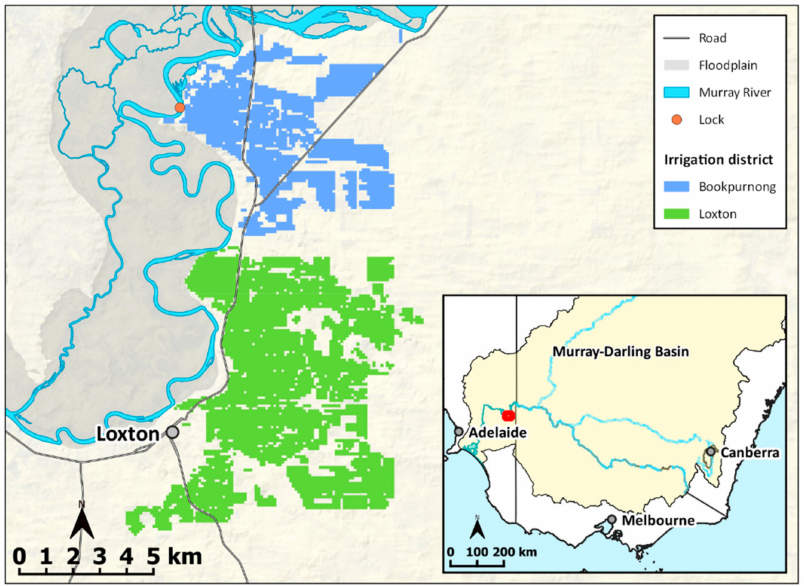
Figure 1. Location of the Loxton and Bookpurnong irrigation districts (the red marking on the inset map shows the location of the study area